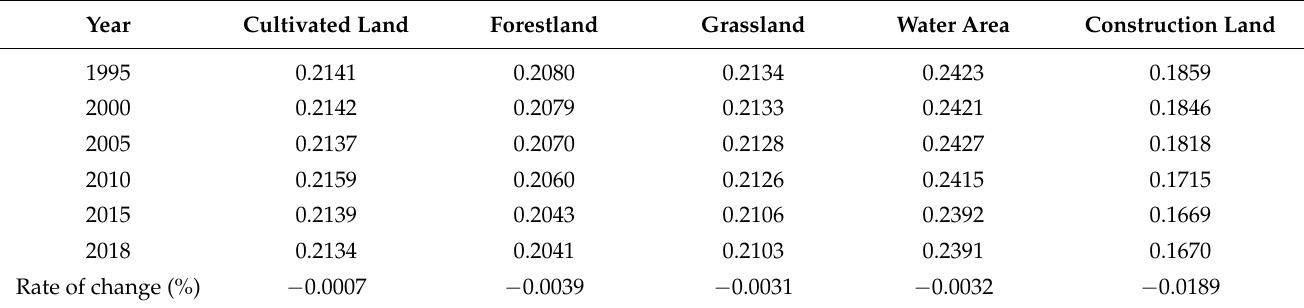
Table 4. Change in average value of LER of different land use types in the Dianchi Lake basin during